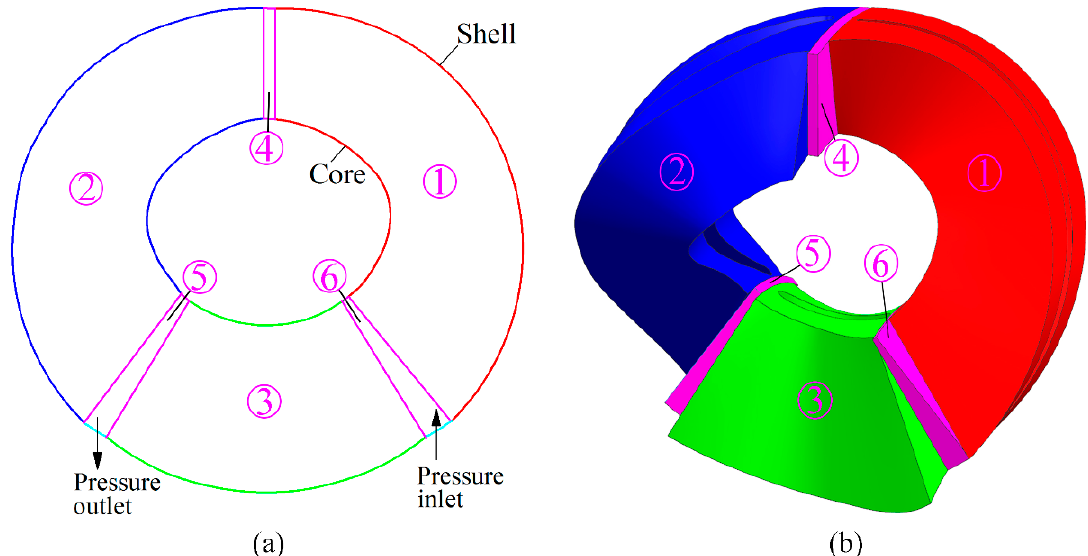
Figure 2. Flow passage layout of the hydrodynamic torque converter. ( a ) torus meridian view and ( b ) single flow passage (1-pump domain, 2-turbine domain, 3-stator domain, 4-P-T clearance domain, 5-T-S clearance domain, and 6-S-P clearance domain).